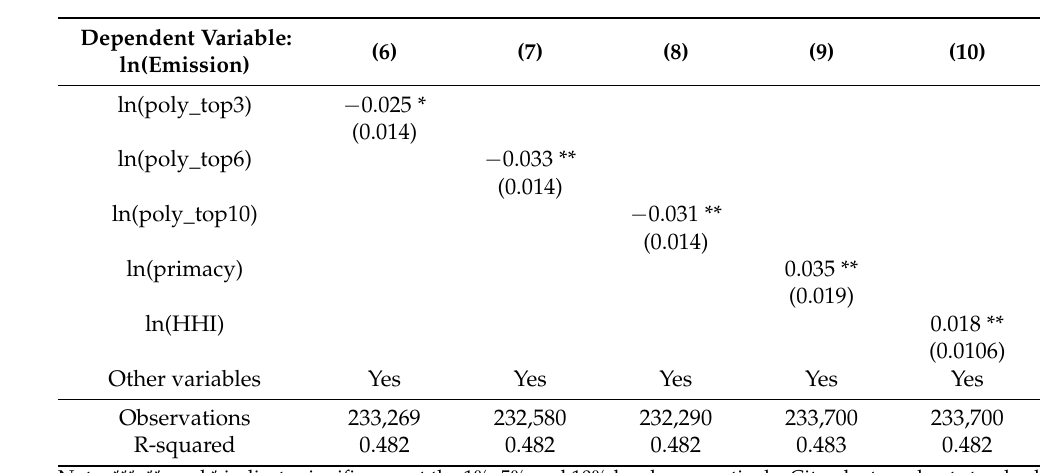
Table 4. Tests for polycentricity robustness.